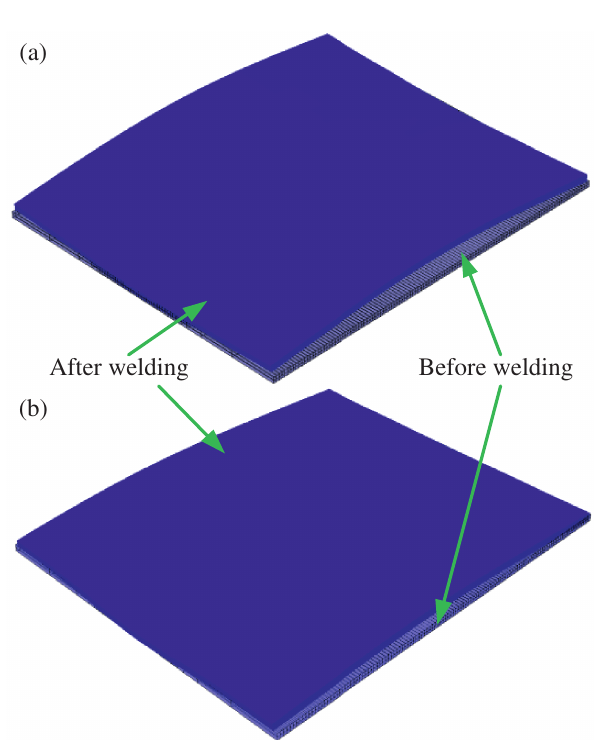
Figure 12: Distortion of workpiece in simulation results: (a) conven- tional cooling and (b)